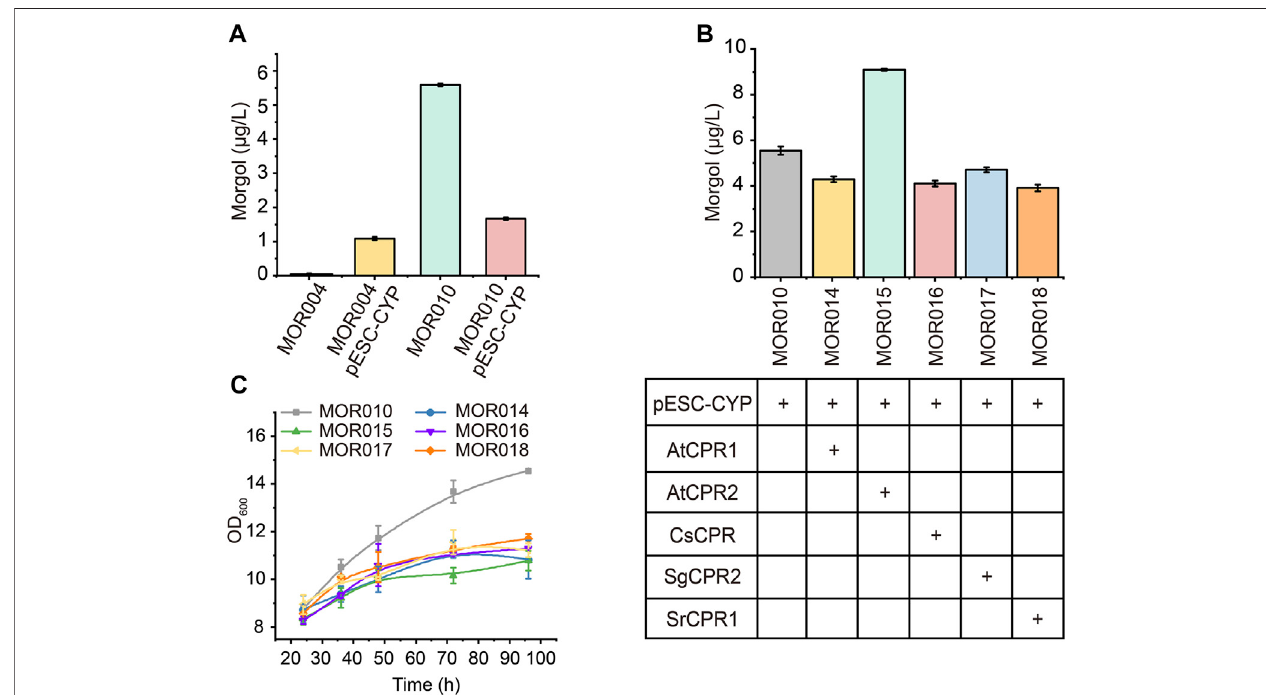
FIGURE 6 | Combined optimization of CYPs-CPRs pairing to improve mogrol production. (A) Mogrol production by overexpressing CYP87D18 using a high-copyplasmid. (B,C) MogrolproductionbyoptimizingCYPs-CPRspairing (B) andcellgrowthcurvesofengineeredstrains (C) ina250-ml fl ask.Errorbarsrepresent the SD of biological triplicates ( n =